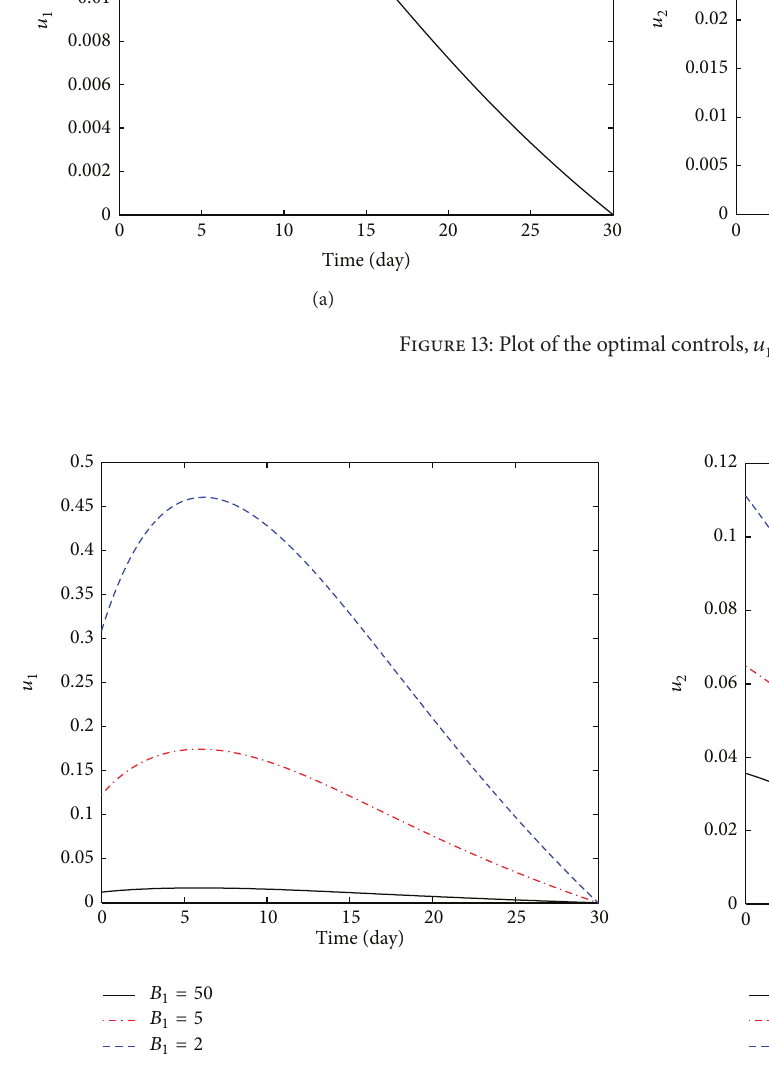
Figure 15: Plot of the number of different weight constants on the control ( 𝐵 2 = 200 , 𝐵 2 = 100 , and 𝐵 2 = 50